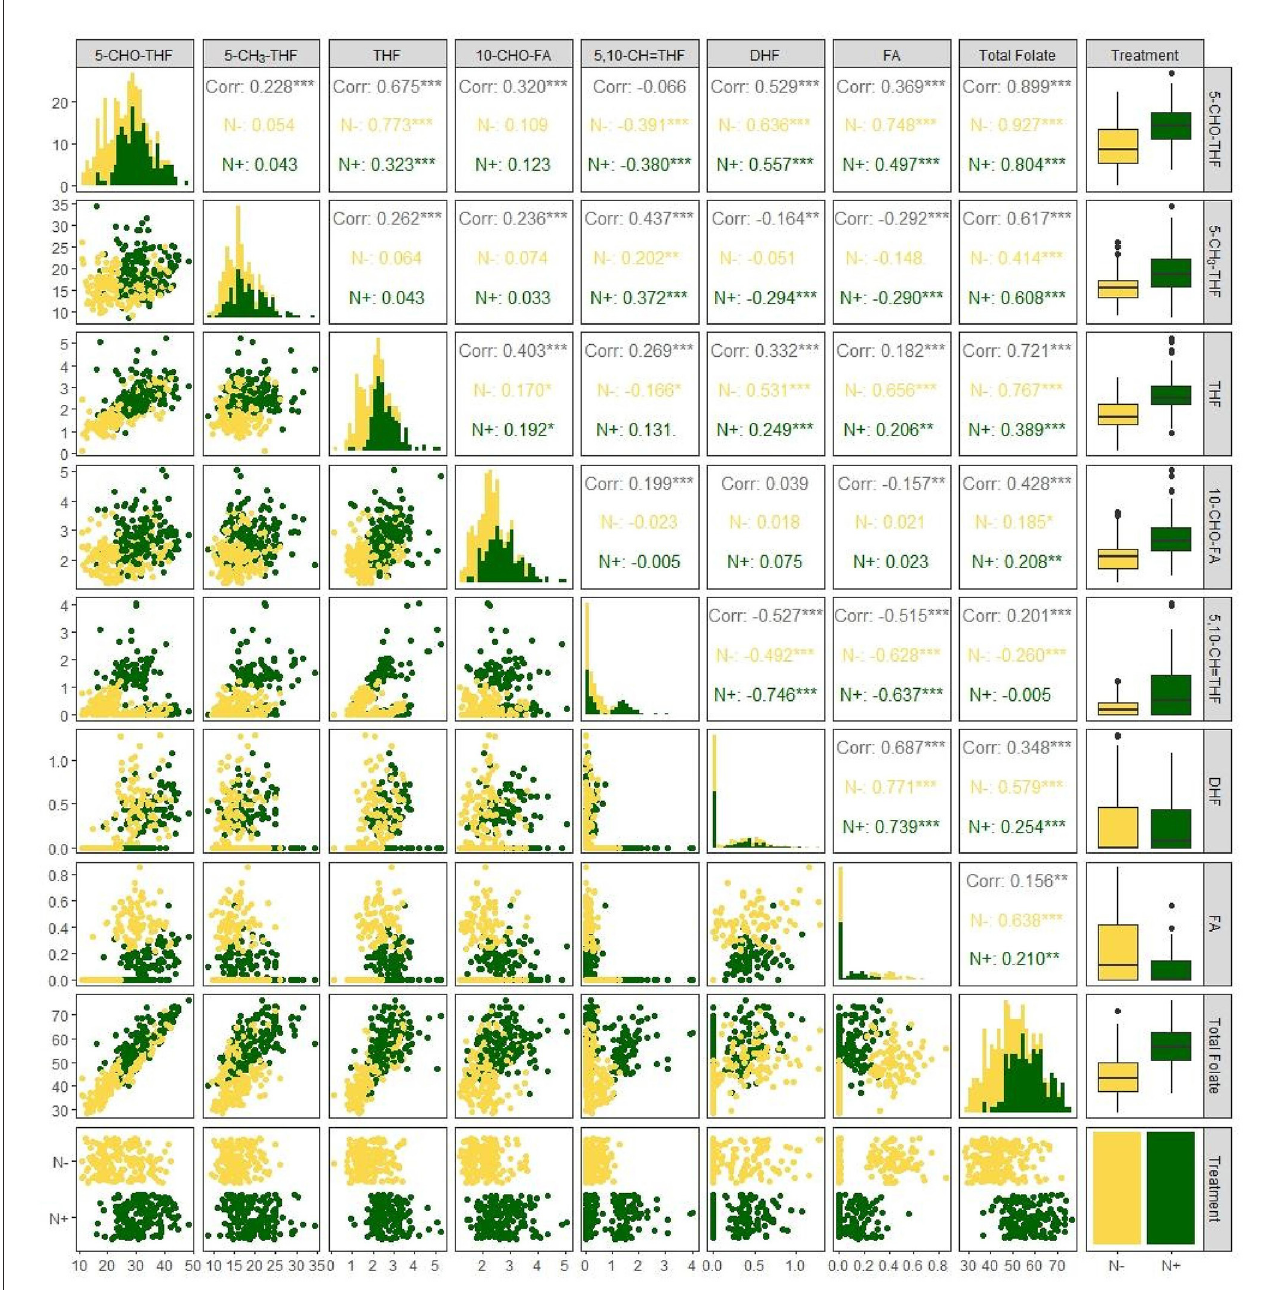
FIGURE4 Correlation among the content of folate derivatives 5–CHO–THF, 5–CH 3 -THF, THF, 10–CHO–FA, 5,10–CH = THF, DHF, FA, and total folate grown with or without N fertilization. N–, N deficiency; N + , N applied treatment. **, *** Indicate significant differences at 0.01 and